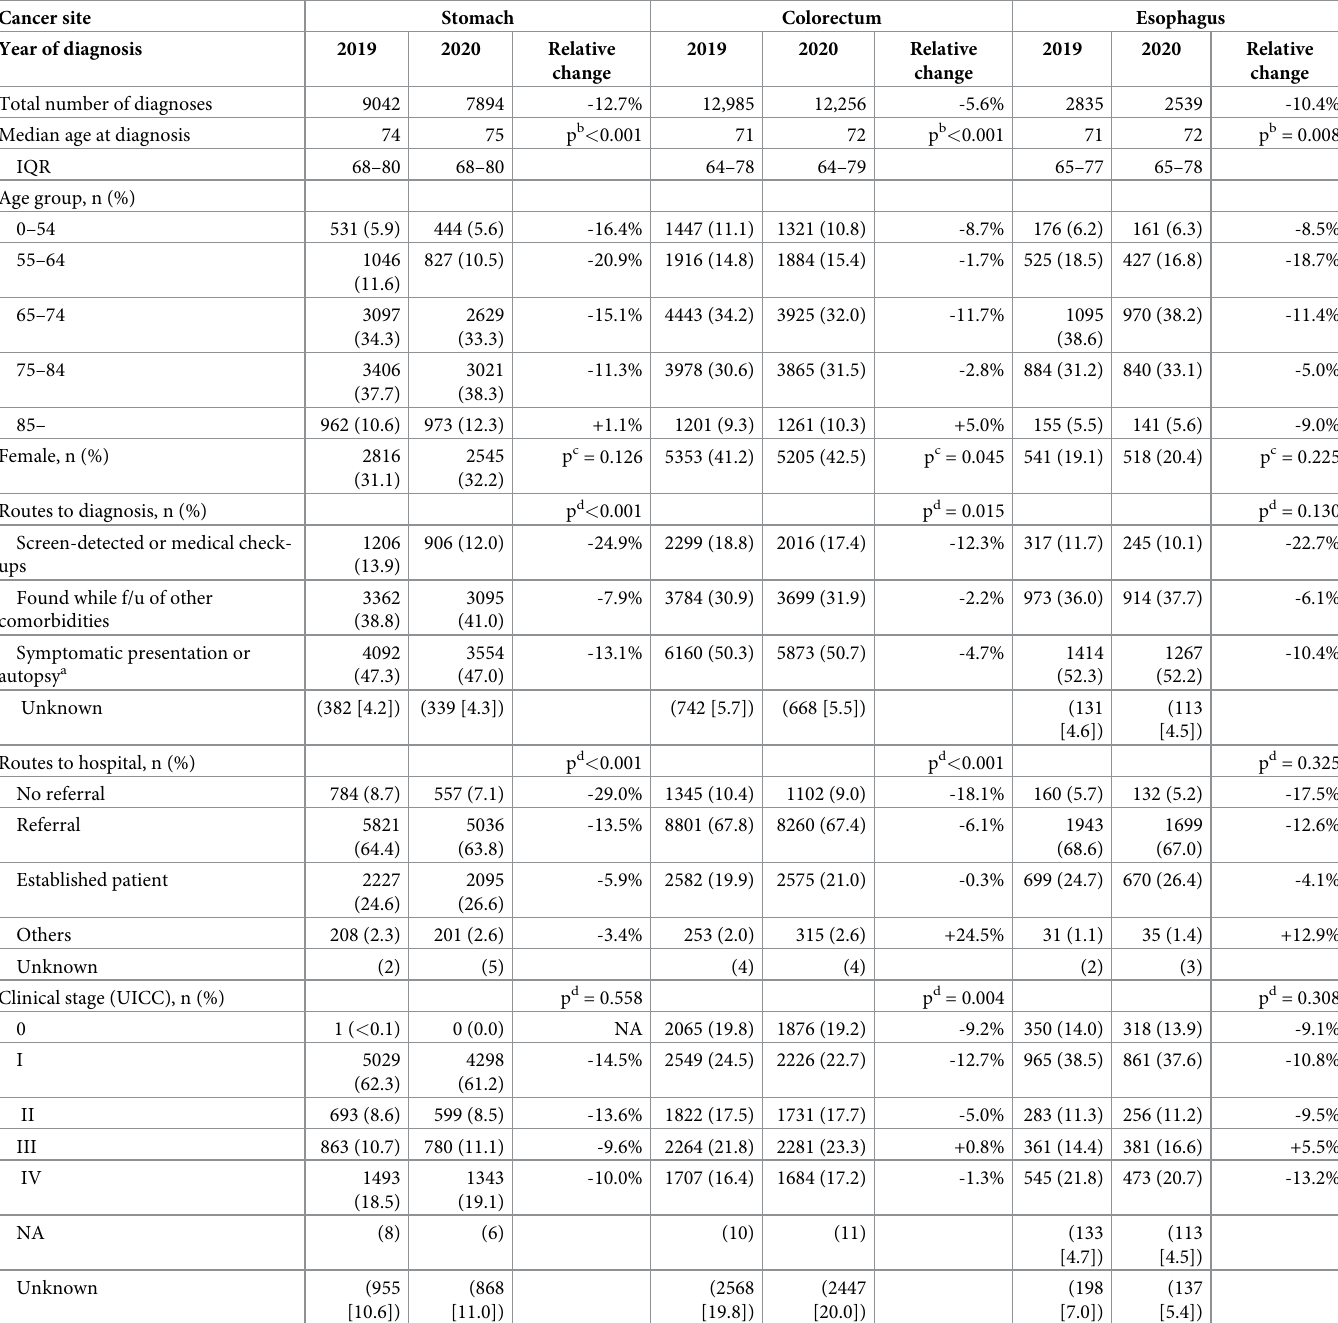
Table 1. Baseline characteristics of patients diagnosed with six digestive cancers in the CanReCO